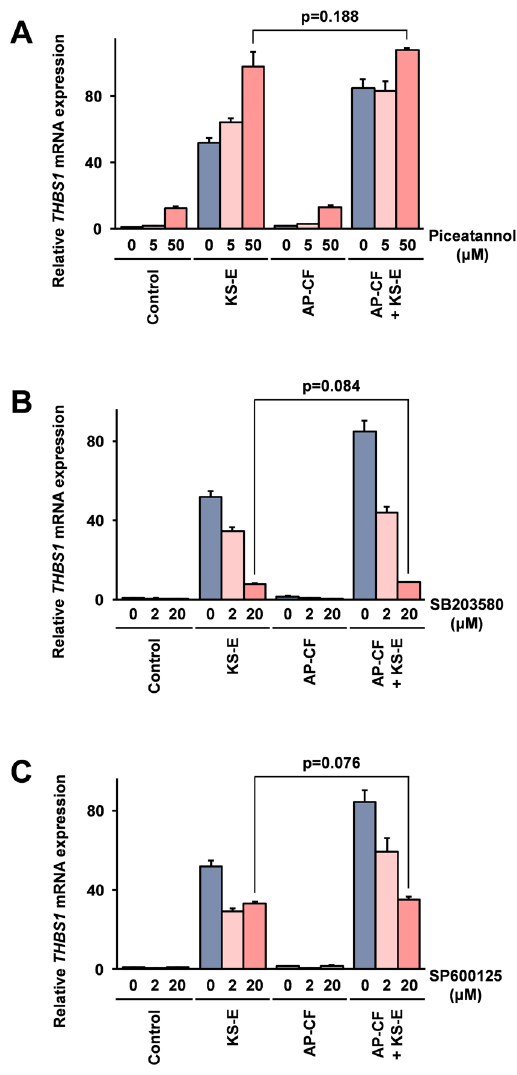
Figure 4. The Syk and its downstream kinases are involved in the enhancement of the THBS1 induction after stimulation with KS-E. Mono Mac 6 cells were treated for 1 hour with piceatannol ( A ), SB203580 ( B ), or SP600125 ( C ) at the concentrations indicated in the figure. Subsequently, the cells were stimulated with a 20-fold dilution of KS-E and AP-CF containing 100 μ g/ml of β -glucan. After an additional 2-hour incubation period the cells were harvested, and the expressions of THBS1 mRNA in the cells were monitored using the real time RT-PCR method. The data are represented as relative values compared with the mRNA expression in the control cells after normalization with GAPDH mRNA expression. Error bars indicate standard deviations calculated by three independent